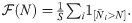
Diversity above competitive exclusion in the non-linear resource competition model, see Sec. Non-linear resource intake.(A) Abundance distribution for different values of migration. The area to the right of the vertical lines hold exactly M species. The rest of the distribution, below the line, accounts for species above competitive exclusion. Inset: the total number of coexisting species normalized by number of resources, with values above one indicate crossing of competitive exclusion. (B) Due to the abundance fluctuations, averaging abundances over a time window pushes the distribution of abundance upwards due to fluctuations. The cumulative abundance distribution is shown, defined as F(N)=1S∑i1[N¯i>N]. The dashed line is the competitive exclusion bound, M/S. For comparison, the distribution at a fixed point is given, showing that the number of species at high abundance(N ≳ 10−3 does not reach this bound, and the rest of the species are at low abundances, only supported by migration.